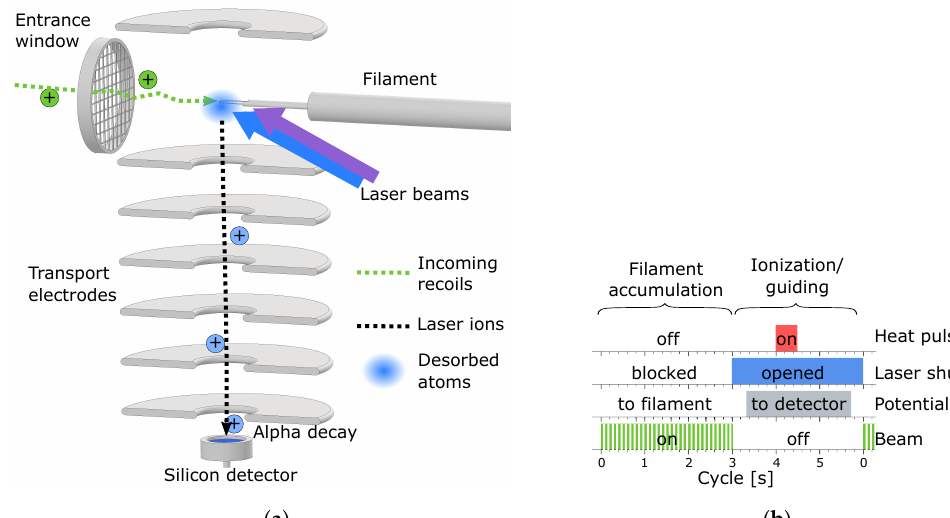
Figure 1. ( a ) Schematic drawing of the RADRIS setup. Incoming fusion products (green) enter the gas cell through the entrance window and thermalize in the 90mbar argon buffer-gas environment. The recoils are collected on a Hf-strip filament, where they adsorb and neutralize. After desorption by pulse-heating the filament, an atomic cloud (blue) is formed around the filament which is illuminated with two lasers following a two-step RIS scheme. Resulting laser ions (blue) are guided towards a silicon detector by applying suitable transport electrode potentials where they are detected via their characteristic alpha-decay energy. ( b ) Previously applied RADRIS cycle for resonance ionization spectroscopy of 155 Yb. Delays between blocking the beam and changing the potentials, as well as applying the filament heat-pulse, are chosen to allow settling down of the stopped recoil ions and complete switching of the voltages, respectively